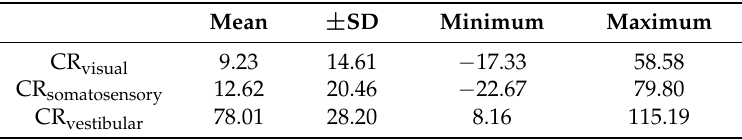
Table 4. Control Ratio (CR) of visual, somatosensory, vestibular contribution given as percentage; negative ratios are due to calculation by the formula by Hegemann et al. [26]; negative or ratios greater than 100% are due to higher values with eyes open vs eyes closed and, respectively floor vs foam surface, respectively.